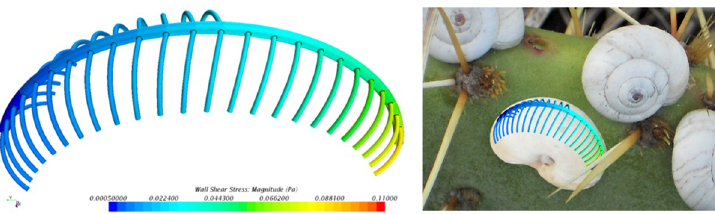
Fig 12. Wall shear stress distribution in the vein system, isolated (left) and superimposed on the in vivo situation